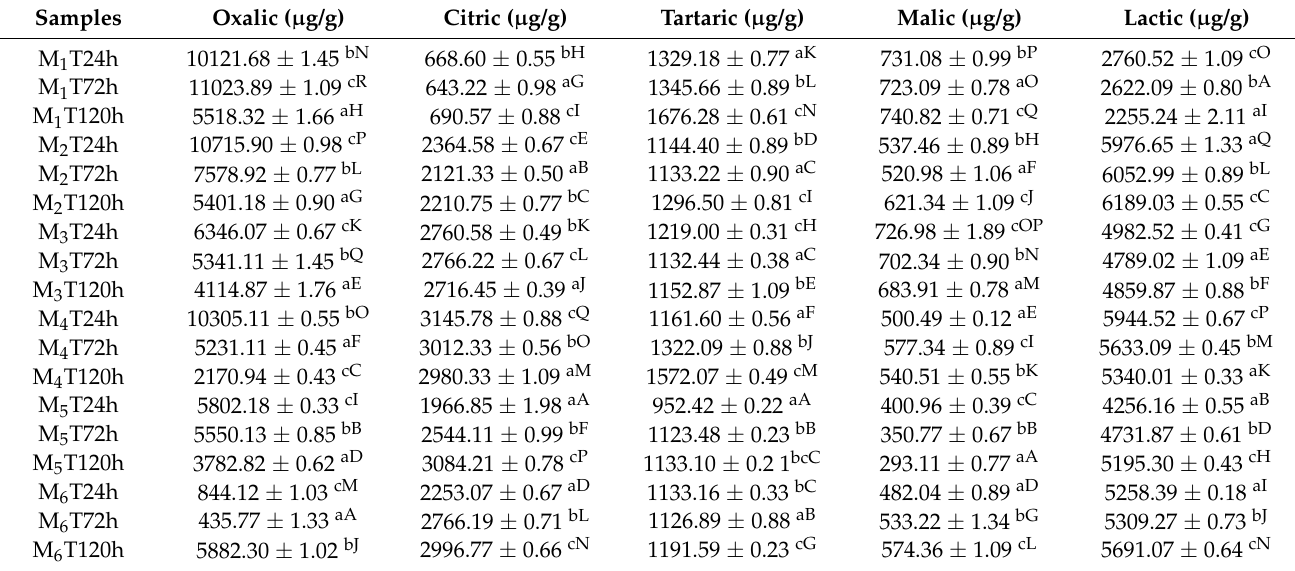
Table 9. Organic acid content of cooked